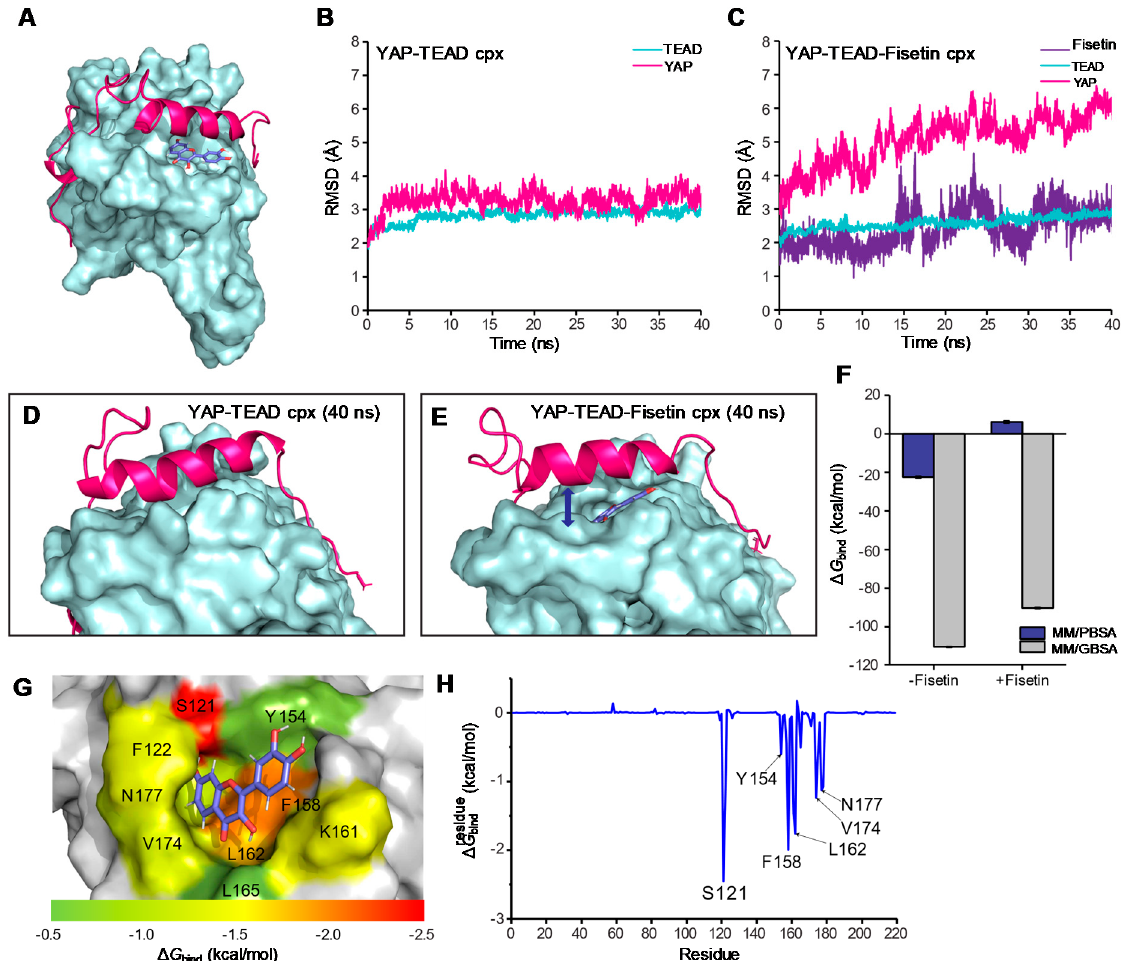
Figure 6. The binding conformation and binding energy of fisetin to the YAP–TEAD complex as predicted by molecular docking and molecular dynamic simulation. ( A ) Overall binding conformation of fisetin to the YAP–TEAD complex. ( B ) All atom RMSD of YAP and TEAD in apo form. ( C ) All atom RMSD of YAP and TEAD in fisetin-bound form. ( D ) The apo form of the YAP–TEAD binding interface at 40 ns trajectory of MD. ( E ) The fisetin-bound form of the YAP–TEAD binding interface at 40 ns trajectory of MD. ( F ) YAP–TEAD binding free energy ( ∆ Gbind) with and without fisetin. ( G – H ) ∆ G residue values of fisetin in complex with TEAD. The important residues involved in fisetin binding are colored according to their ∆ G residue values .